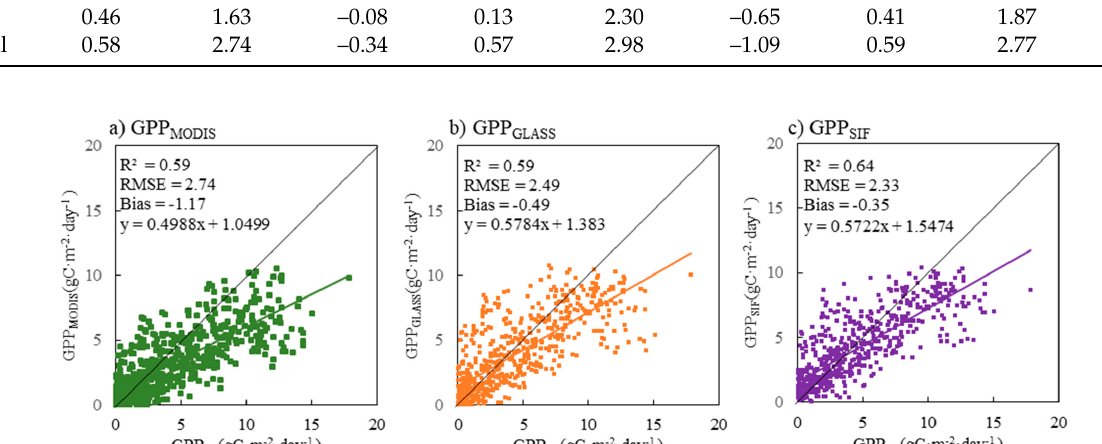
Scatter plots between GPP MOD and GPP EC , and scatter plots between GPP GLASS and GPP EC , and scatter plots between GPP SIF and GPP EC were analyzed in 2014, as shown in Figure 2. R 2 between GPP MOD and GPP EC was 0.59, RMSE was 2.74 g C·m –2 ·day –1 , and Bias